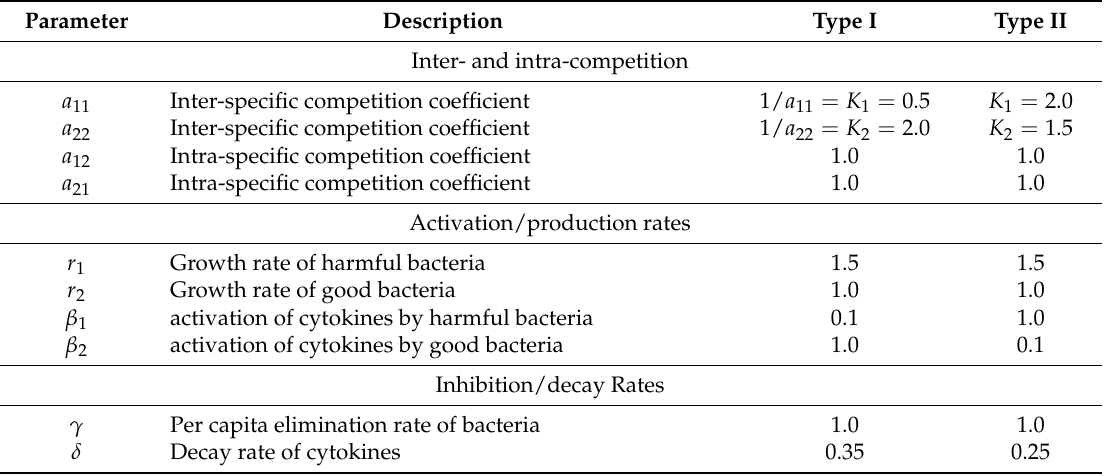
Table 4. Parameters used in the M2